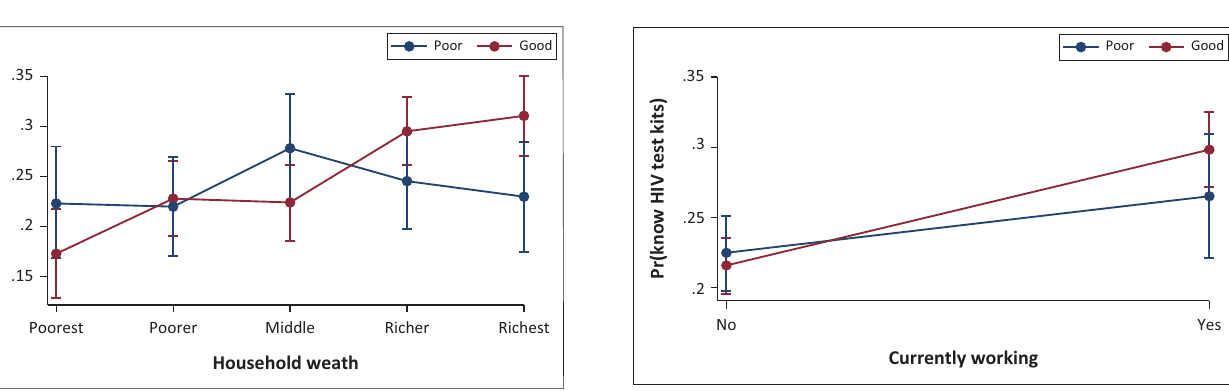
FIGURE 2: Predictive marginal effects of HIV test kits knowledge by household wealth and HIV infection knowledge.